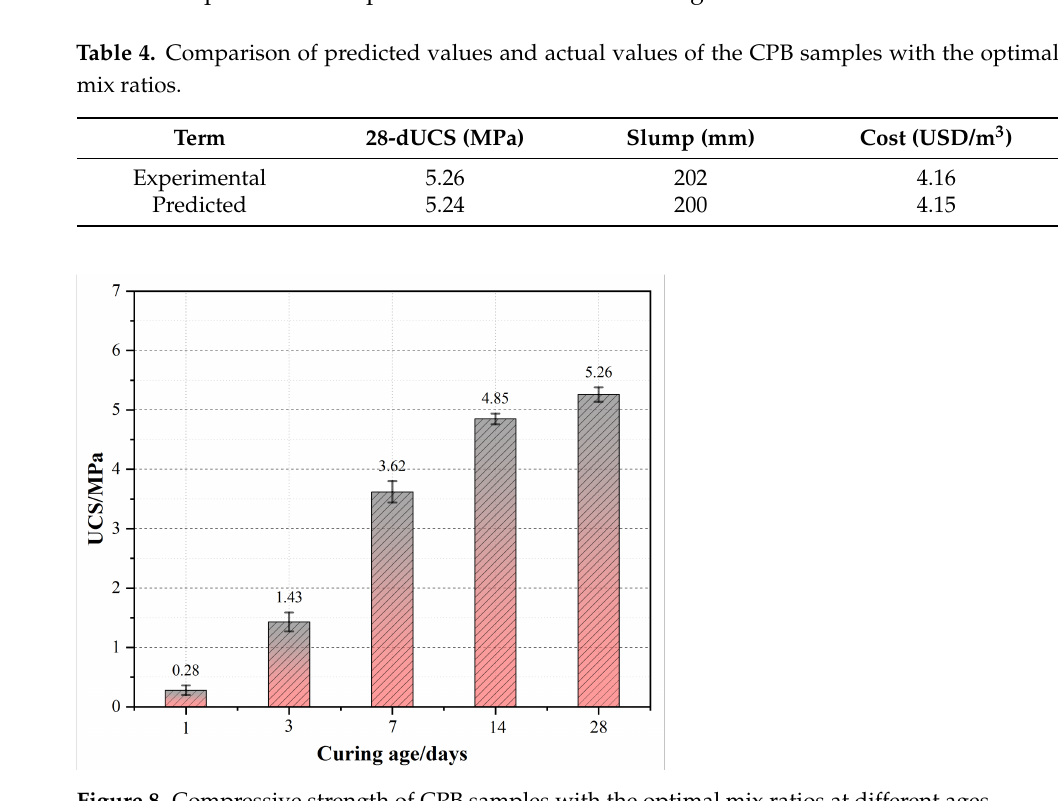
Figure 8. Compressive strength of CPB samples with the optimal mix ratios at different